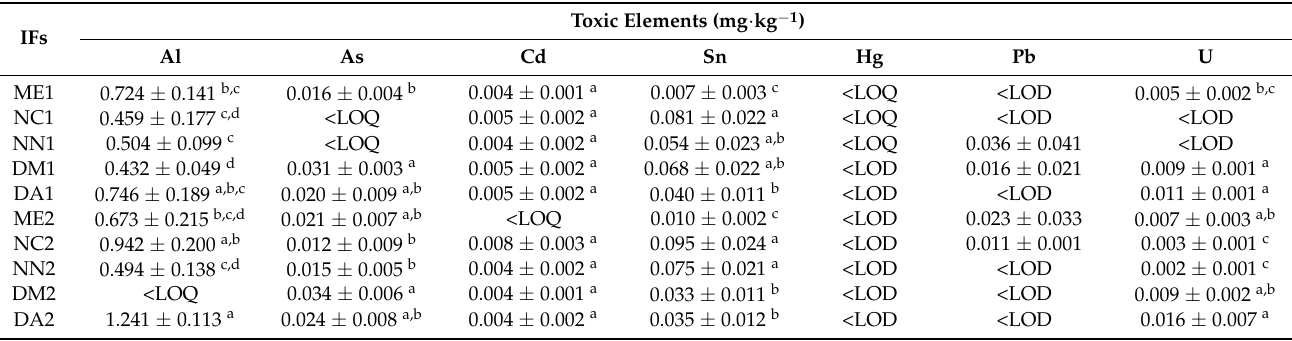
Table 3. Average concentrations of toxic elements in phase 1 and phase 2 infant formulas marketed in